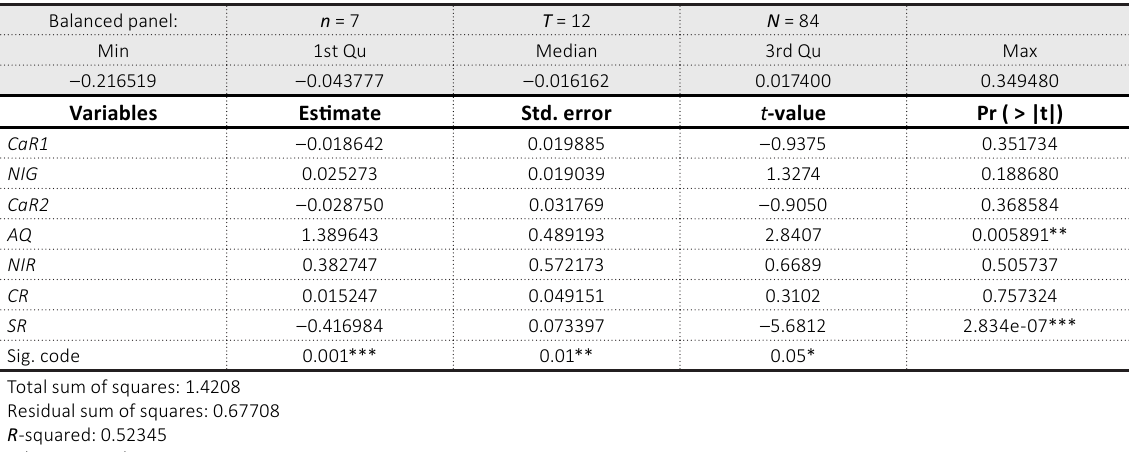
Table 5. Fixed effect regression model on Return on